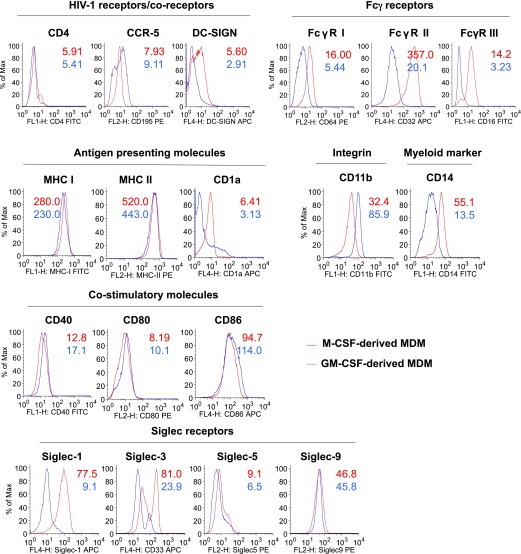
Expression of cell surface molecules on GM-CSF– and M-CSF–derived MDMs.Primary human monocytes from an HIV-seronegative donor were differentiated into MDMs following in vitro culture in GM-CSF (blue line) or M-CSF (red line) media for 5 d. Cells were harvested, stained, and the expression of cell surface molecules was analyzed by flow cytometry. The numbers in the histograms represent the MFIs of the indicated receptors. A representative histogram of 3 independent experiments performed in triplicate is shown. DC-SIGN, dendritic cell–specific intercellular adhesion molecule 3-grabbing nonintegrin; max, maximum.